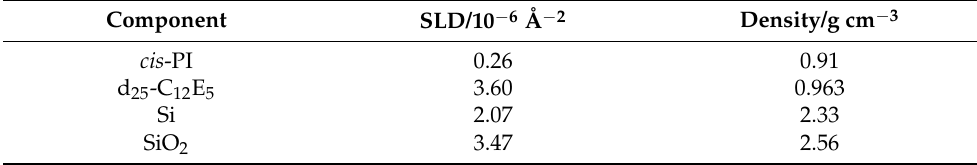
Table 1. Scattering Length Densities for Hydrogenous and Deuterated